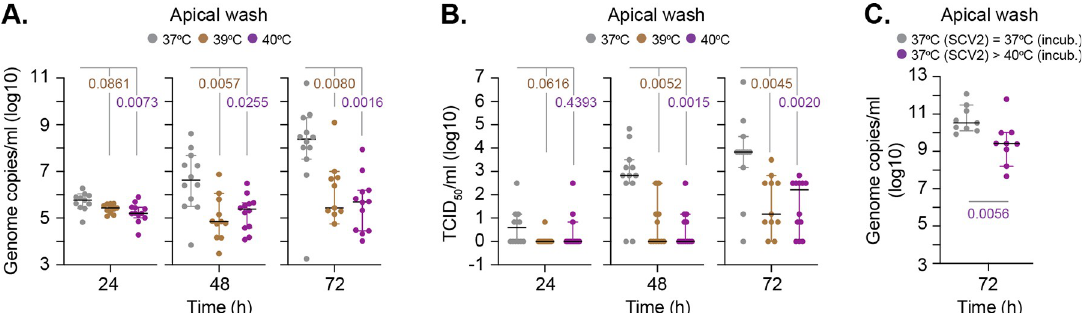
Fig 3. Elevated temperature restricts SARS-CoV-2 replication in respiratory airway cultures. Ciliated respiratory cultures differentiated from HBEp cells isolated from donor 1 (male Caucasian aged 63 years) were incubated at 37, 39, or 40˚C for 24 h prior to SARS-CoV-2 (SCV2; MOI 0.05, 10 4 PFU/Tissue) infection and incubation at the indicated temperatures. Apical washes were collected over time (as indicated). (A) Genome copies per ml of SARS-CoV-2 in apical washes were determined RT-qPCR. N � 11 tissues per condition derived from a minimum of 3 independent biological experiments. Black line, median; whisker, 95% confidence interval; all data points shown; p -values shown, one-way ANOVA Kruskal–Wallis test. (B) TCID 50 assay measuring infectious viral load in apical washes harvested from SARS-CoV-2–infected respiratory cultures. N � 11 tissues per condition derived from a minimum of 3 independent biological experiments. Black line, median; whisker, 95% confidence interval; all data points shown; p -values shown, one- way ANOVA Kruskal–Wallis test. (C) Ciliated respiratory cultures were infected with SARS-CoV-2 (MOI 0.05, 10 4 PFU/Tissue) at 37˚C and incubated for 24 h prior to continued incubation at 37 or temperature upshift to 40˚C. Genome copies per ml of SARS-CoV-2 in apical washes collected at 72 h were determined RT-qPCR. N = 9 tissues per condition derived from a minimum of 3 independent biological experiments. Black line, median; whisker, 95% confidence interval; all data points shown; p -value shown, Mann–Whitney U test. Raw values presented in S9 Data. HBEp, human bronchiolar epithelial; PFU, plaque-forming unit; RT-qPCR, reverse transcription quantitative PCR; SARS-CoV-2, Severe Acute Respiratory Syndrome Coronavirus